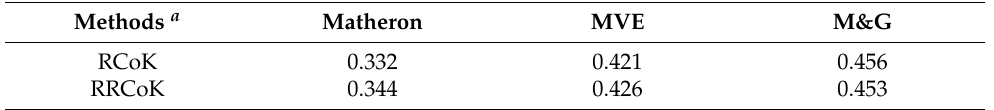
Table 3. The medians of θ ( u ) , calculated based on leave-one-out cross-validation for determination of the optimal cross-variograms.